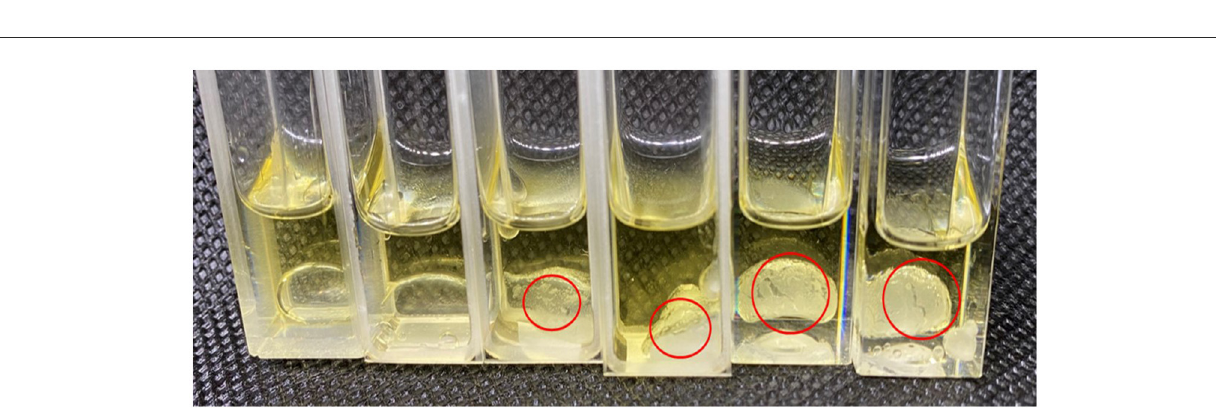
surface of the green fluorescence-labeled GO droplets, forming a red–green “sandwich” structure, which reflected the fact that the particle emulsifier adsorbed on the oil–water interface to form O/W Pickering emulsion. In addition, the dispersion of the droplets was poor, and the β -CD particles were unevenly distributed and seriously agglomerated at the interface by observing the surface structure of a single droplet. These results indicated that